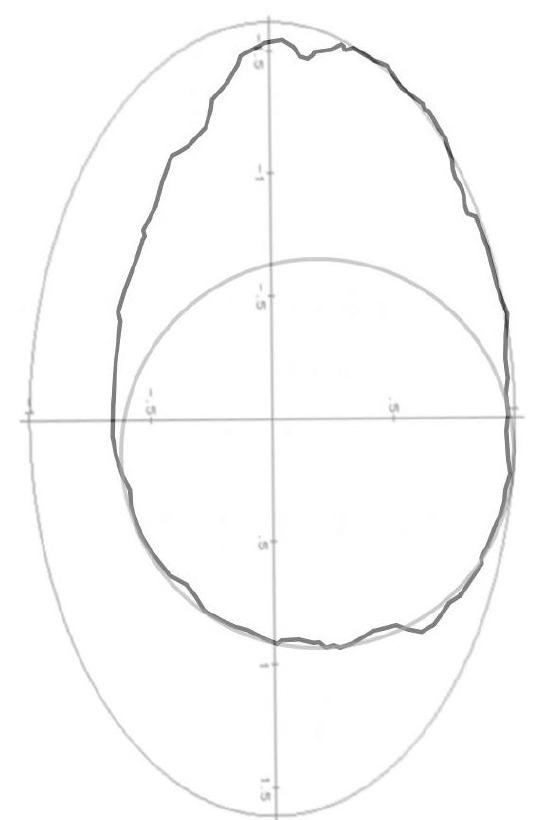
Figure 18. Outline of Specimen 40416, Lynford Quarry (from author’s